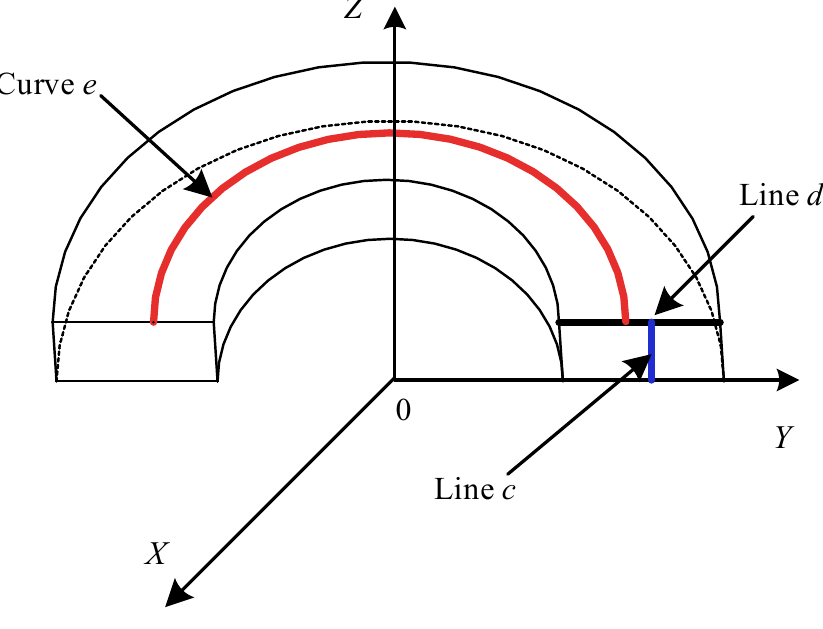
Figure 6. Half section of friction